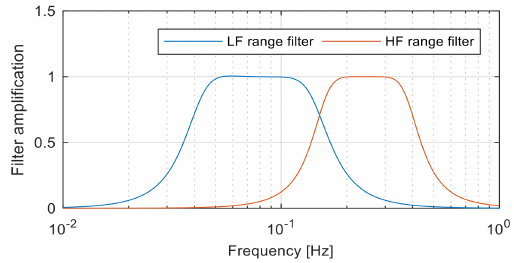
Figure 7. Frequency response of decomposition